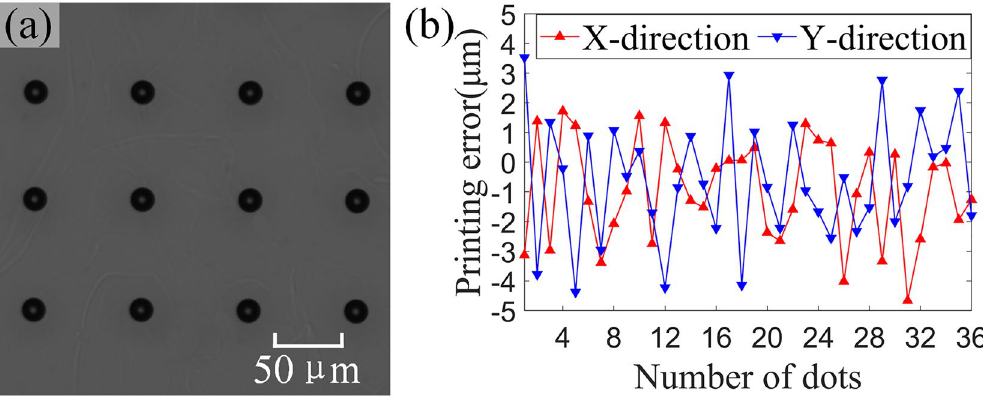
Figure 9. Droplet deposition accuracy. ( a ) Droplet deposition positions. ( b ) Droplet deposition accuracy in the X direction and Y